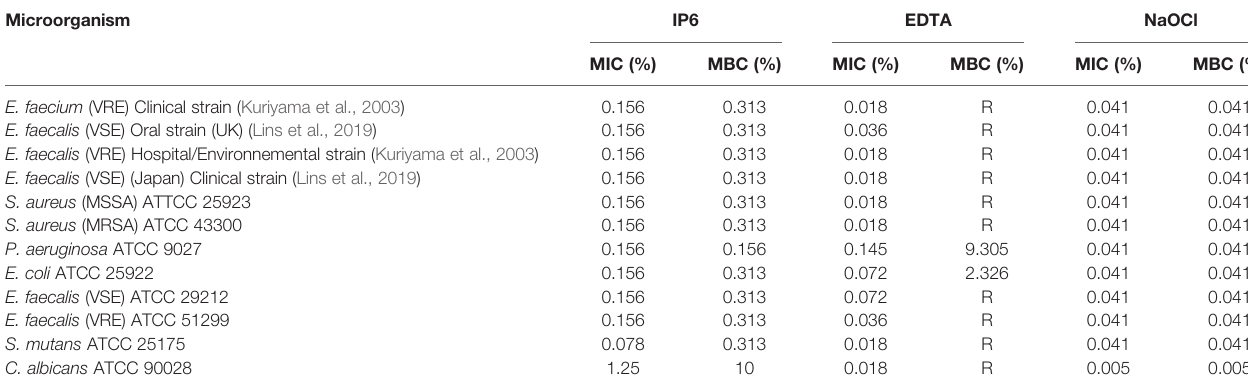
TABLE 2 | Minimum inhibitory concentration (MIC) and Minimum bactericidal concentration (MBC) of IP6, EDTA and NaOCl against test microorganisms.